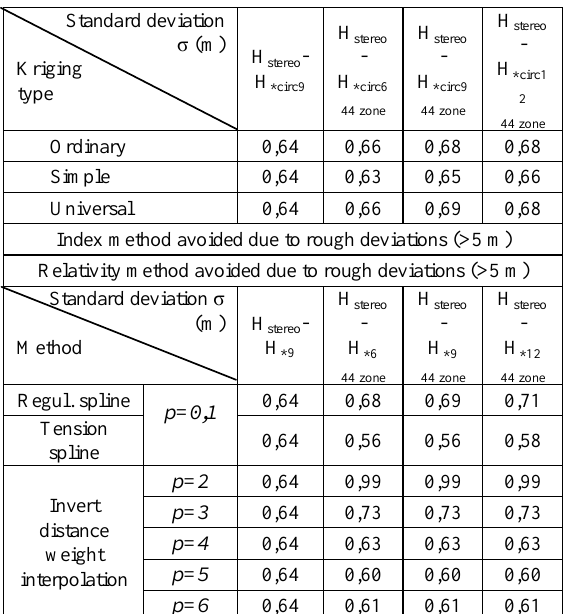
Table 4. Standard deviations of DEM built by different methods in area